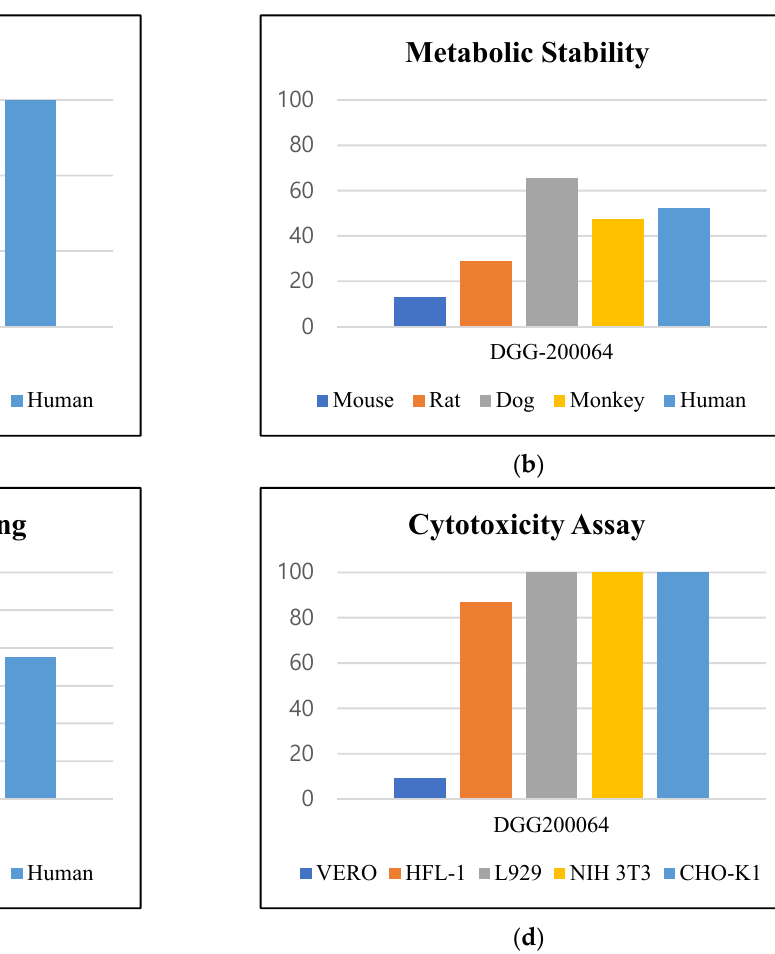
Figure 7. Pharmacological analysis of representative lead compounds DGG200064 : ( a ) Plasma Stability (% remaining after 4 h incubation in plasma); ( b ) Metabolic Stability (liver microsomal phase I stability, % of remaining after 30 min incubation); ( c ) Plasma protein binding (%, the rate at 5 μ M);